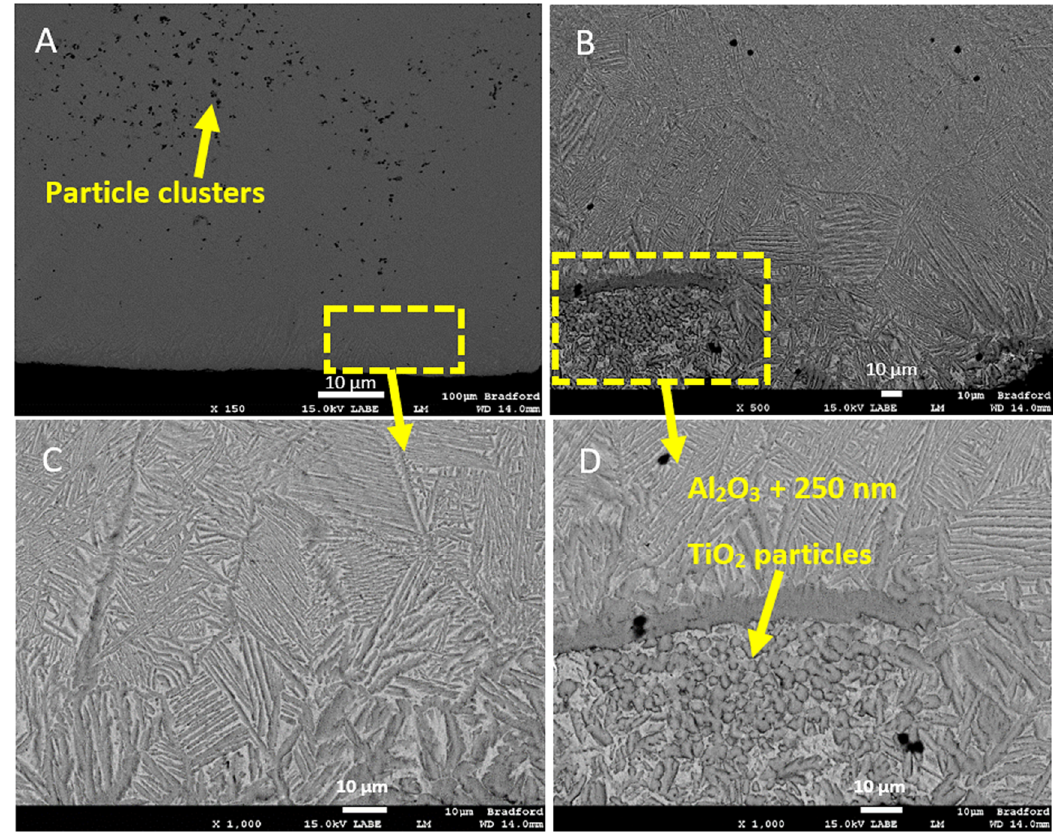
Figure 6. SEM micrographs of Ti-6Al-4V sample electrodeposited with Ni / Al 2 O 3 + 250 nm diameter TiO 2 particles and surface melted with a welding current of 75 A and quenched in air. ( A ) Low-resolution image of the treated layer. ( B ) Particle segregation during the solidification process. ( C ) Detailed view of highlighted region-1. ( D ) Detailed view of highlighted region-2.